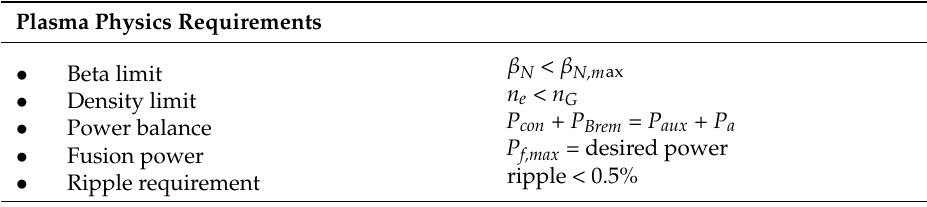
Table 2. Plasma physics, technology and neutronic